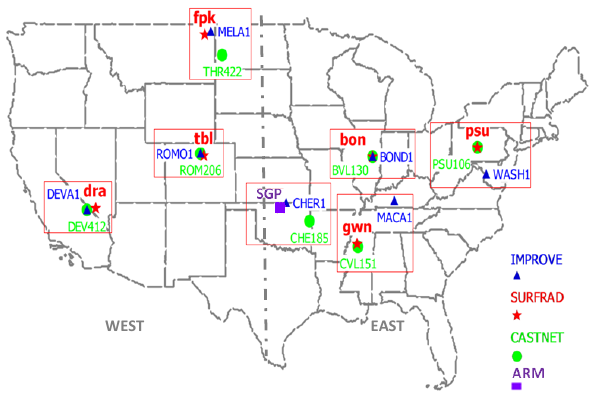
Figure 1: Locations of various sites in SURFRAD, ARM, CASTNET and IMPROVE 2 Fig. 1. Locations of various sites in SURFRAD, ARM, CASTNET and IMPROVE networks. 3